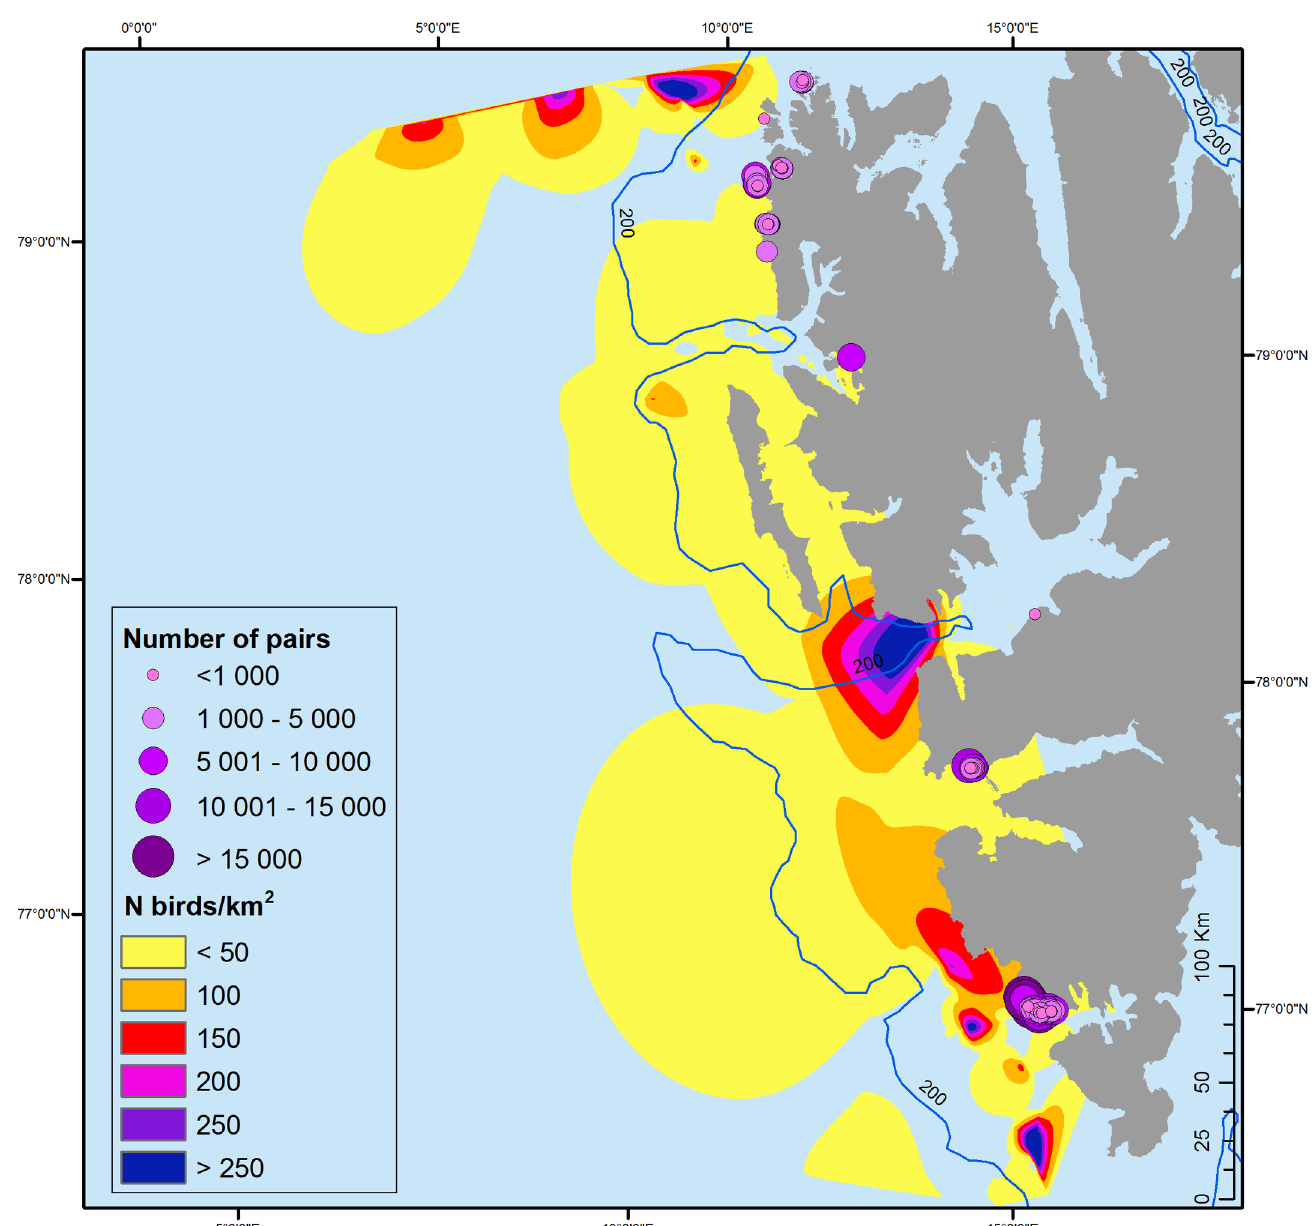
Fig 3. Location of the little auk foraging hotspots interpolated from data from at-sea surveys. Circles on land represent little auks colonies. The size of the circle refers to the estimated colony size (the number of breeding pairs). Background (bathymetry and contour map): NOAA Satellite Maps. main concentration of little auks on the West coast of Spitsbergen: Hornsund). The size of all random polygons was the same (2 900 m 2 ) and was set to the mean size of the measured colony patches. The random polygons were then validated visually based on the aerial images. The polygons located on glaciers, flat rocky islets (unlikely location of little auk colonies) or at known colony patches position were excluded leaving 194 polygons meeting all the above crtieria.